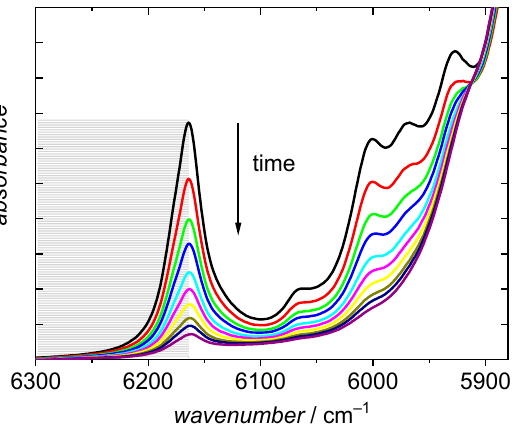
Figure 4. NIR spectra recorded during a BA polymerization in dioxane. Temperature and initial monomer concentration are 150 °C and 3.69 mol·L –1 , respectively. The final spectrum refers to a reaction time of 30 min.